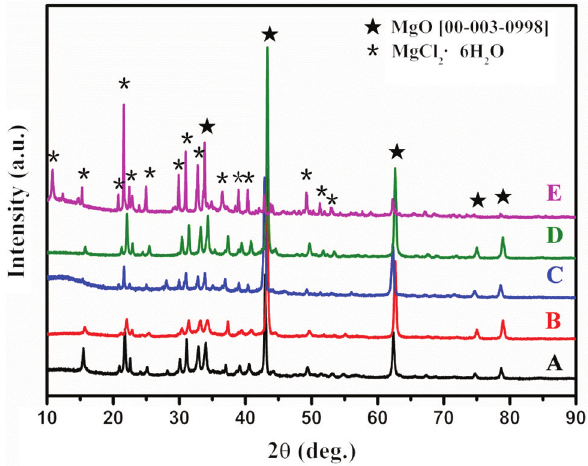
Figure 2 X-ray diffraction (XRD) patterns of the products synthe- sized by the radio frequency (RF) induction thermal plasma process with different precursor feeding rates: (A) 0.30 ml/min; (B) 0.60 ml/ min; (C) 0.90 ml/min; (D) 1.20 ml/min; and (E) 1.50 ml/min.